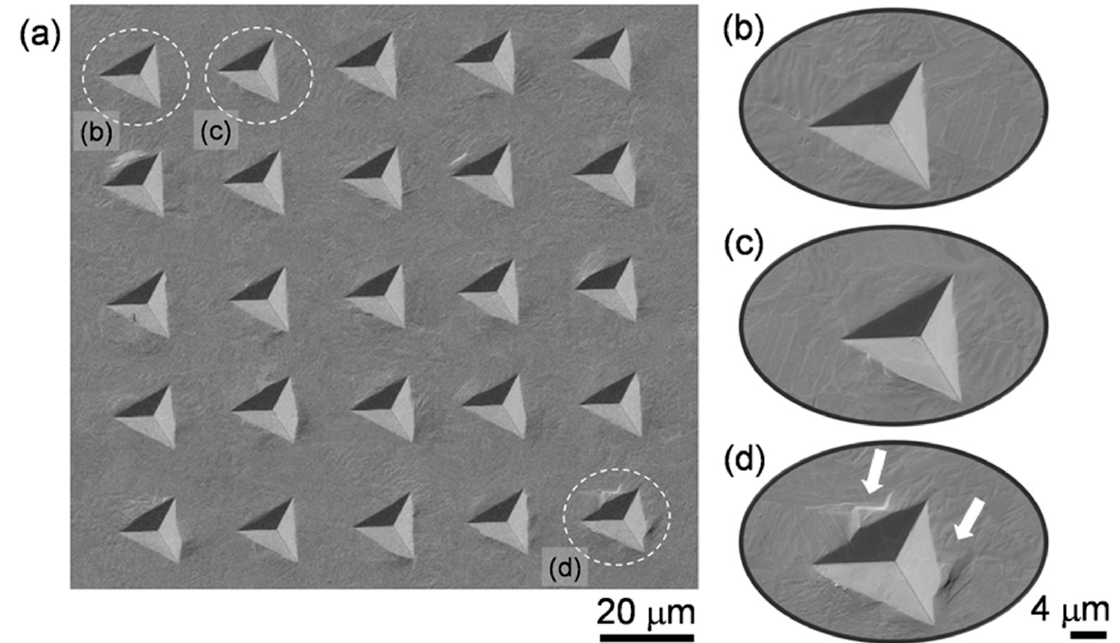
Figure 11. FESEM micrographs showing the residual imprints. ( a ) General view of the array of the residual imprints; ( b – d ) FESEM magnifications of some residual imprints in order to show the different deformation features .